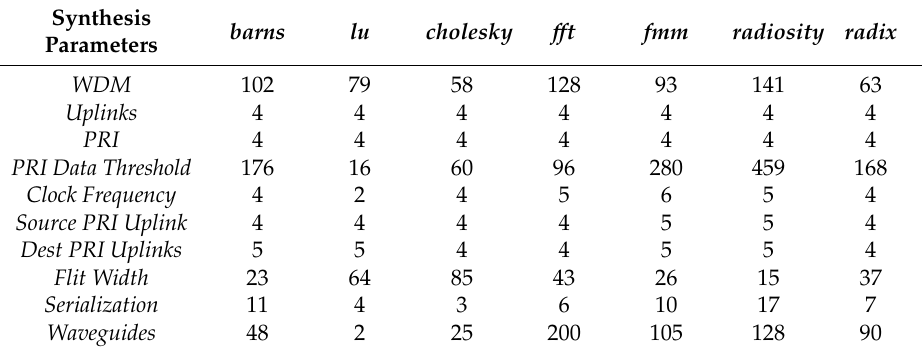
Table 5. Simulated Annealing Synthesis Results.